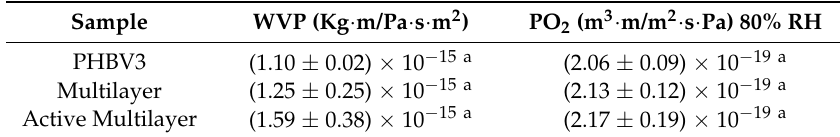
Table 3. Water vapor (WVP) and oxygen permeability (PO 2 ) measurements of the neat PHBV3 and PHBVs films and the silver-based coating systems.